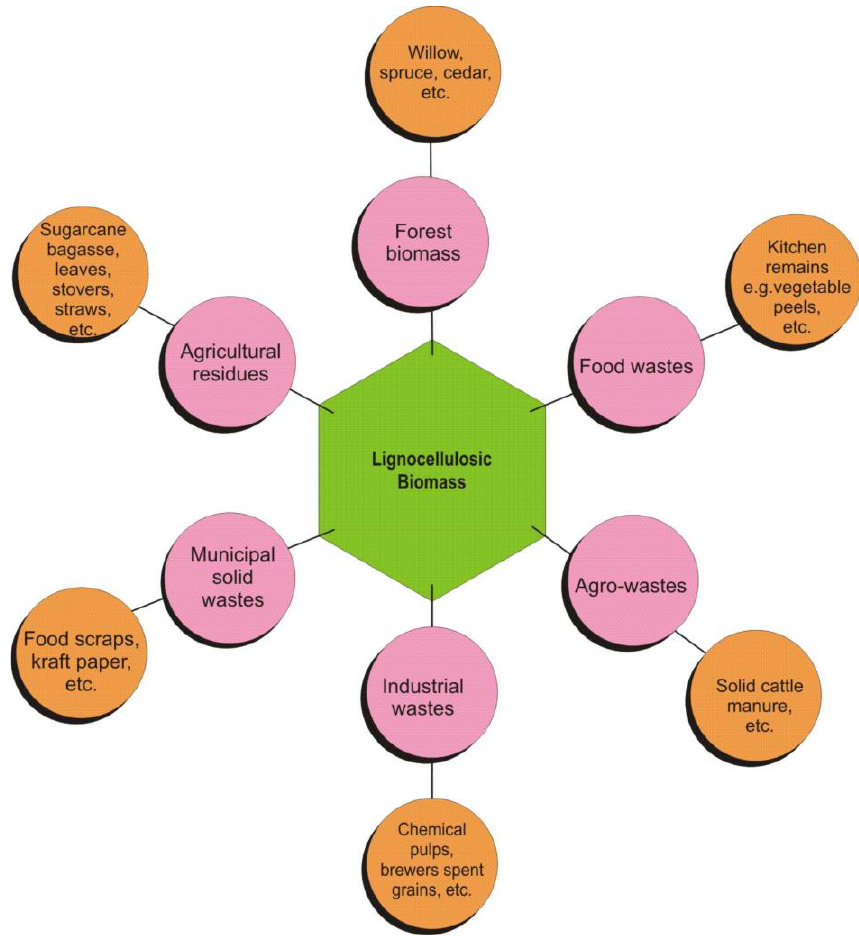
Figure 4. Block diagram of different lignocellulosic biomass sources (Data from Sharma et al. (2023) [65], Adewuyi (2022) [66], and Kumar et al. (2009) [56]). Sugarcane bagasse and brewer spent grains are promising lignocellulose mass recently used as feedstock for lactic acid production. Sugarcane bagasse is a fibrous residue obtained after the juice has been extracted from the sugarcane stalk [67,68] . The brewer’s spent grains are a brewing by-product obtained during beer brewing [69]. Converting lig- nocellulosic biomass into lactic acid involves four process steps: pretreatment, hydrolysis, fermentation, and product separation or purification using a suitable microorganism(s) operating at a selected operational mode. 4. Pretreatment Processes of Lignocellulosic Materials Due to the complexity of the lignocellulosic materials, pretreatment is a key technol- ogy used in bio-based industries [70]. The pretreatment of lignocellulosic materials allows the removal of lignin and hemicellulose, reduces the crystallinity of cellulose, and in- creases the porosity of lignocellulosic materials [56]. In the pretreatment step, biomass macroscopic and microscopic, and chemical compositions are disrupted to achieve more rapid hydrolysis of carbohydrate polymer that produces greater yields of monomeric sug- ars [55]. Different methods employed in pretreating lignocellulosic materials, as presented in Figure 5, include physical (grinding or milling, pyrolysis, etc.), physicochemical (steam explosion, ammonia fiber explosion (AFEX), carbon dioxide, etc.), chemical (e.g., dilute acid hydrolysis, alkaline hydrolysis, organosolv process, oxidative delignification, ozo- nolysis, etc.), biological (using ligninolytic enzymes of certain microorganisms) pretreat- ments [51,52,71,72].